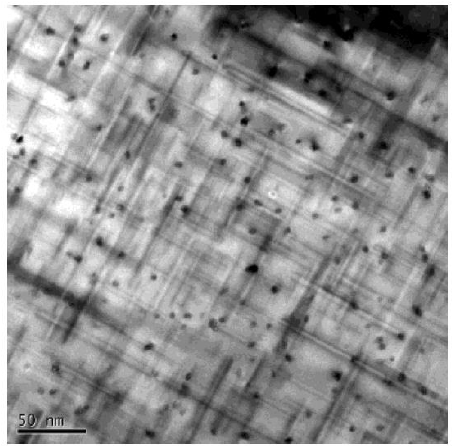
Figure 8. Bright-field TEM images of the as-solutionized alloy aged at 180 °C for 12 h with zone axis [001] Al.